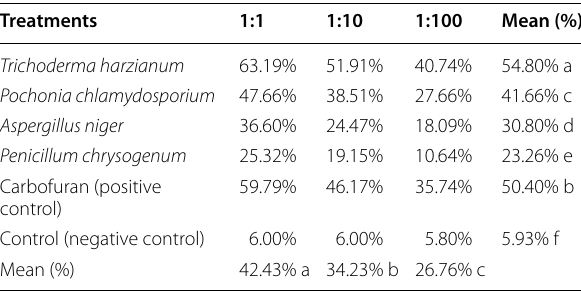
Each value is the mean of 5 Replications. A letter followed by the same alphabet doesn’t differ significantly